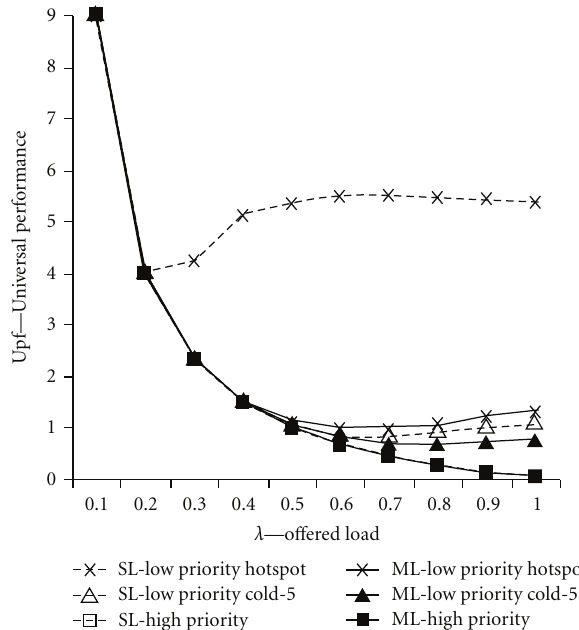
Figure 8: Universal performance metric of a dual-priority, double- bu ff ered, 6-stage MIN under hotspot tra ffi c at a multilayer architec- ture.